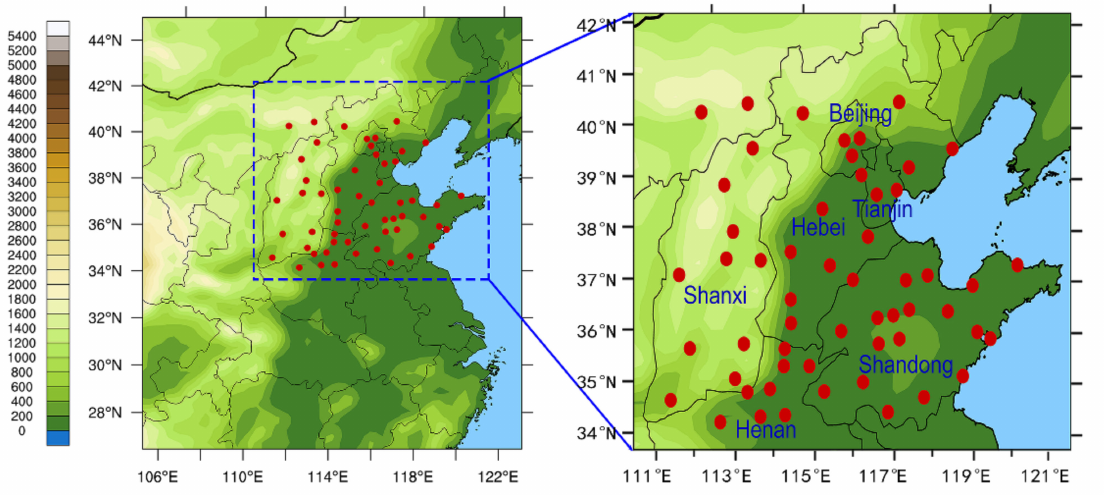
Figure 1. Model domain with the terrain altitude and province boundary. The larger domain on the left covered the mainland of China, while the blue dotted rectangle represents the NCP region, which is shown in a zoomed-in view to the right. Black solid lines represent the province boundary and blue font shows the names of the provinces. Red dots indicate the position of ground-based SO 2 monitoring